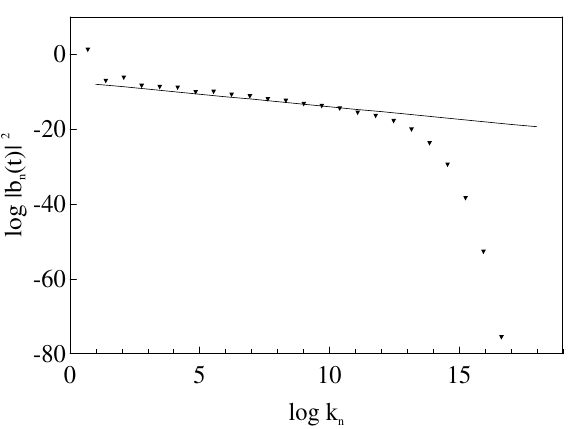
Figure 88: We show the magnetic energy spectrum | 𝑏 𝑛 ( 𝑡 ) | 2 as a function of log model. The full line refer to the Kolmogorov spectrum 𝑘 − 2 / 3 𝑛